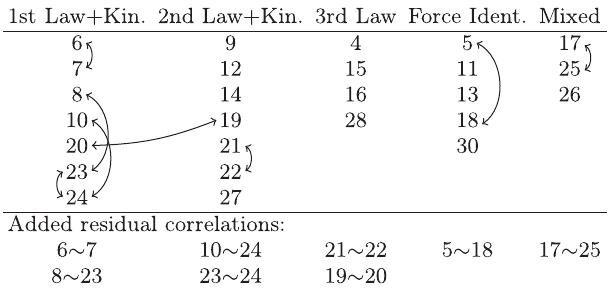
of the model, however since EW5 combines Newton ’ s laws and their associated kinematics, question 20 appears in a